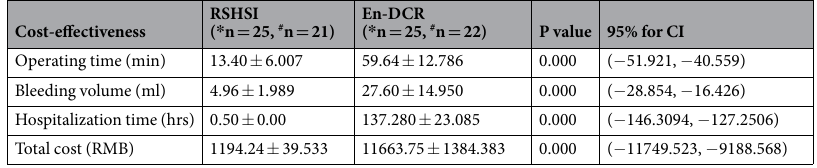
Table 5. Comparison of cost-effectiveness between the two kinds of operation. Two-tailed independent t test. CI, Confidence Interval. * n, the number of operative eyes in each group. # n, the number of NLDO patients in each group. Operating time and bleeding volume was analysed based on * n. Hospitalization time and total cost was analysed based on # n.